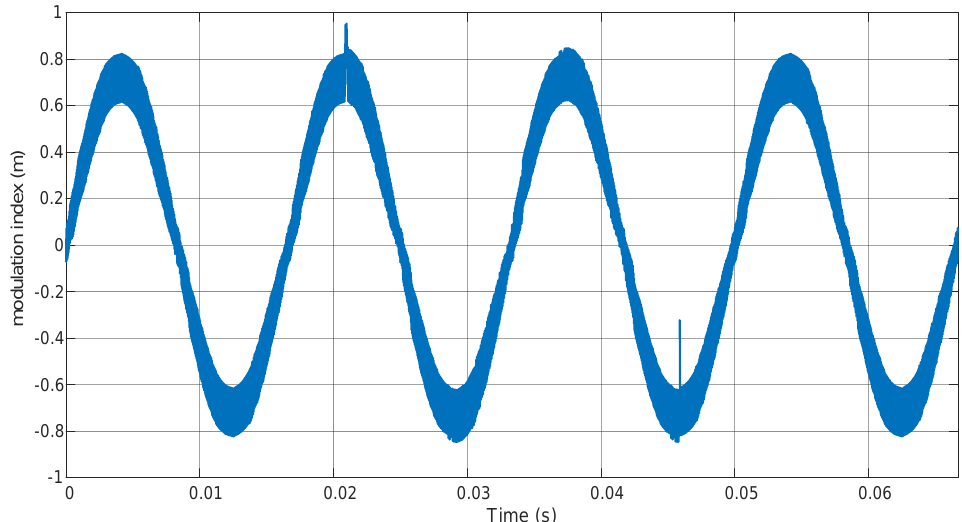
Figure 10. Control action 𝑢 𝑠𝑚𝑐 over time to produce the switching states. Another criterion that can be used to study the effectiveness of the control is the THD, which is present in the grid current. For this scenario, the harmonic current spectrum is displayed in Figure 11.